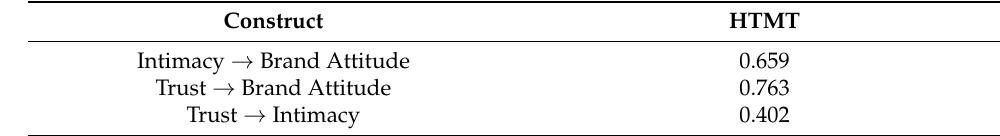
Table A4. Discriminant Validity of Full Sample (N = 45).